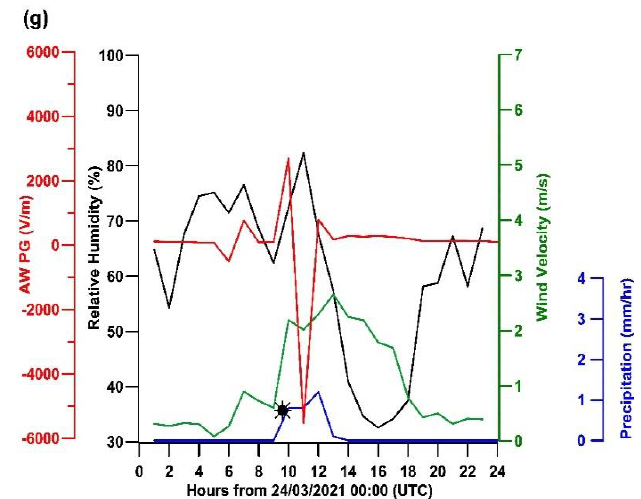
Figure 4. Hourly PG, RH, wind velocity and precipitation rate of: ( a ) Snow event 22/12/2011; ( b ) Snow event 02/02/2012; ( c ) Snow event 26/01/2014; ( d ) Snow event 26/02/2018; ( e ) Snow event 27/02/2018; ( f ) Snow event 14/02/2021; ( g ) Snow event 24/03/2021; The asterisk denotes the start of snowfall.